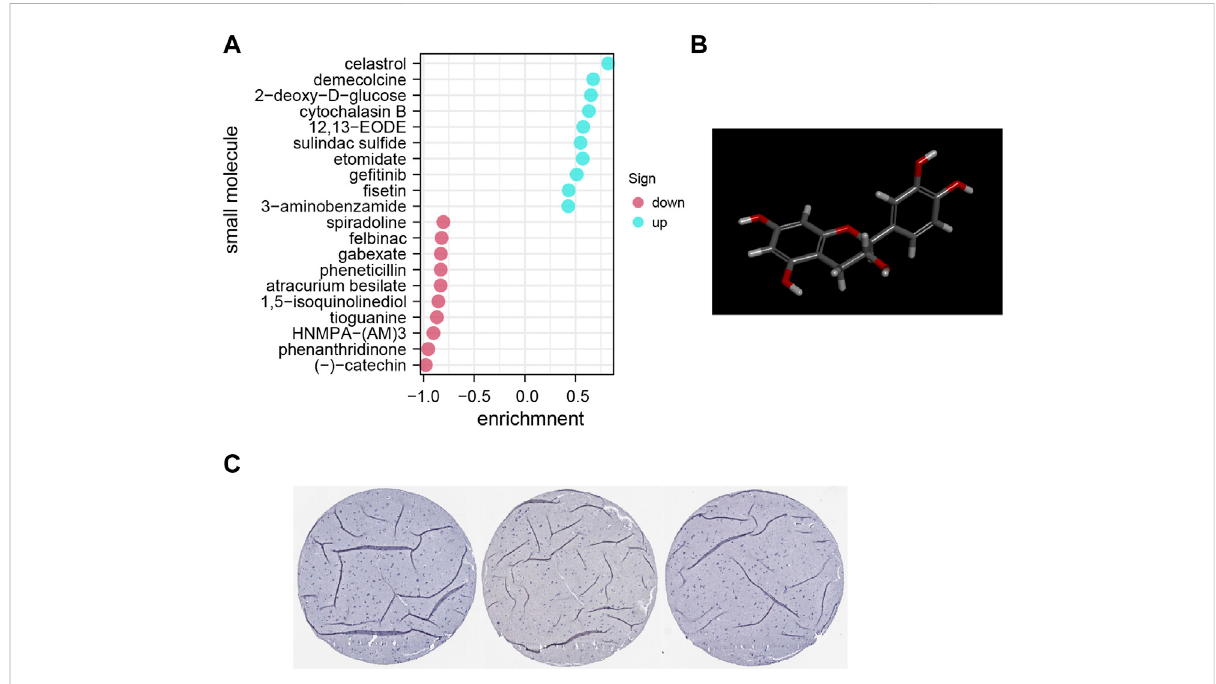
FIGURE 5 (A) Pop plot showing the top 20 small compounds capable of reversing gene expression. (B) Structure of top molecule. (C) Representative immunohistochemistry staining results reveal the protein level expression of ACE2 in brain